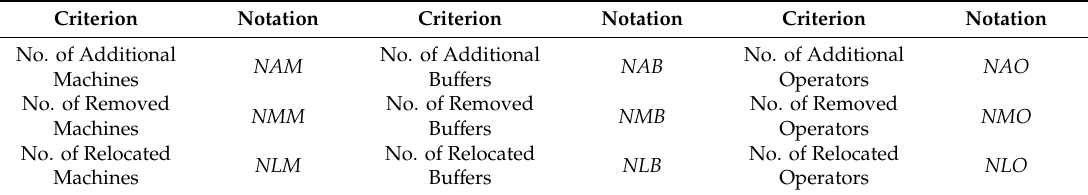
Table 2. Strategic Table 2. Strategic indicators.